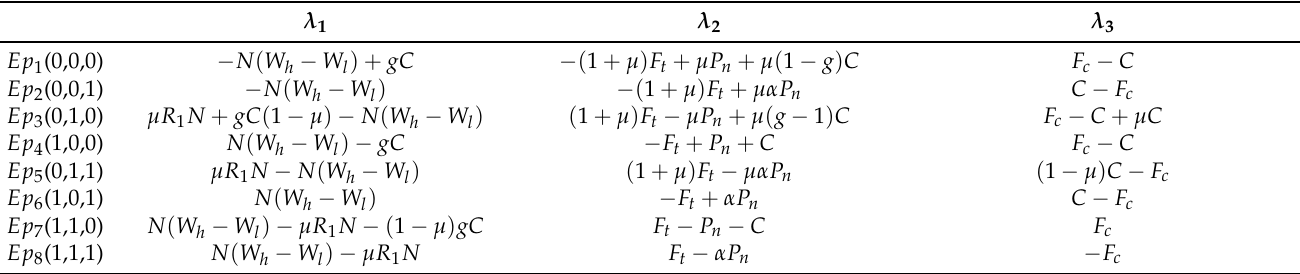
Table 3. System equilibrium points and eigenvalues.